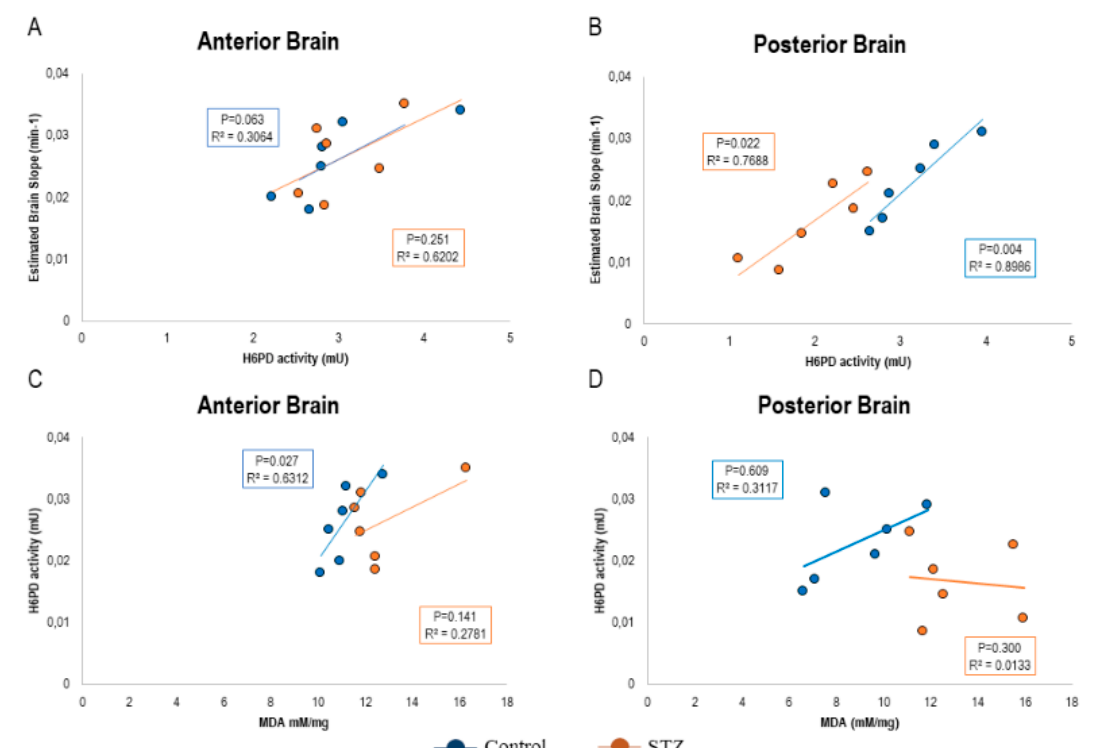
Figure 6. Correlation between FDG uptake, Hexose-6-phosphate dehydrogenase (H6PD) enzymatic activity, and the hyperglycemia-related redox damage at a regional level. The correlation plots between the slope of Patlak regression, H6PD enzymatic activity, and malondialdehyde (MDA) content are displayed in the anterior (Panels A and C ) and posterior brain (Panels B and D ) of control (blue) and STZ (brown) mice. Due to the design of the study protocol, only 12 mice ( n = 6 controls and n = 6 STZ) underwent both FDG PET and biochemical analyses. R 2 and P values of the Pearson correlations are reported in each panel.